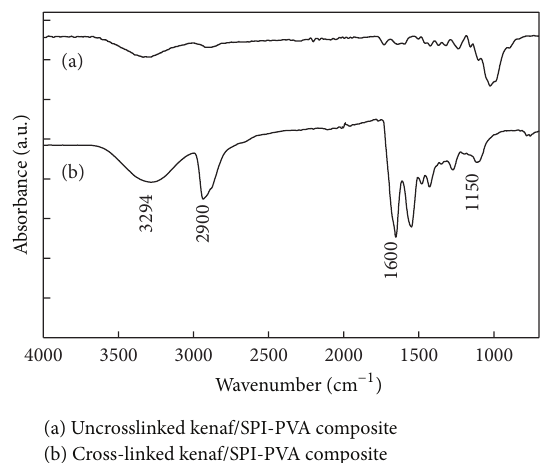
Figure 11: FTIR spectra of the uncross-linked and cross-linked kenaf/SPI-PVA composite.